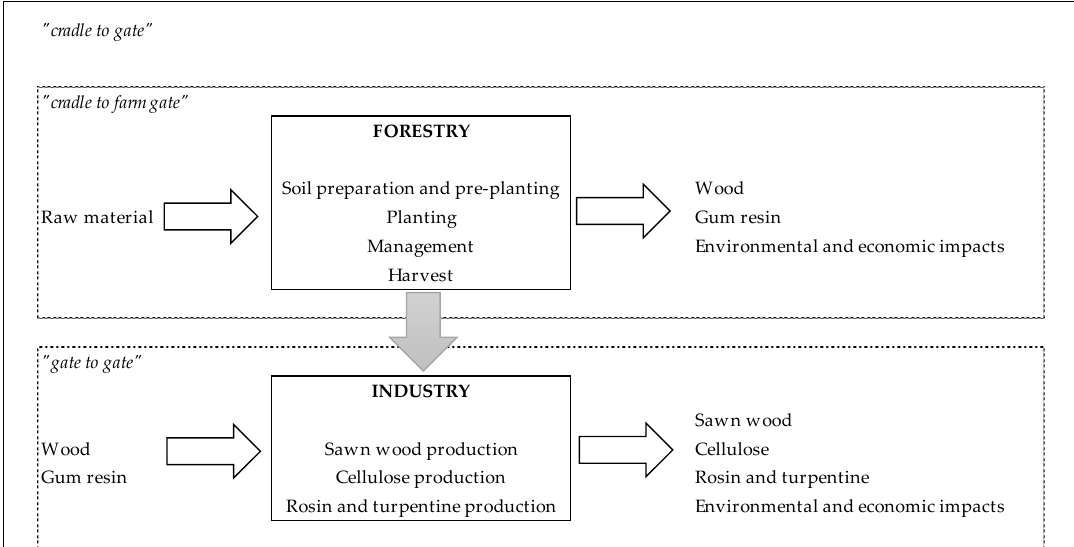
Figure 2. Scope of the study.